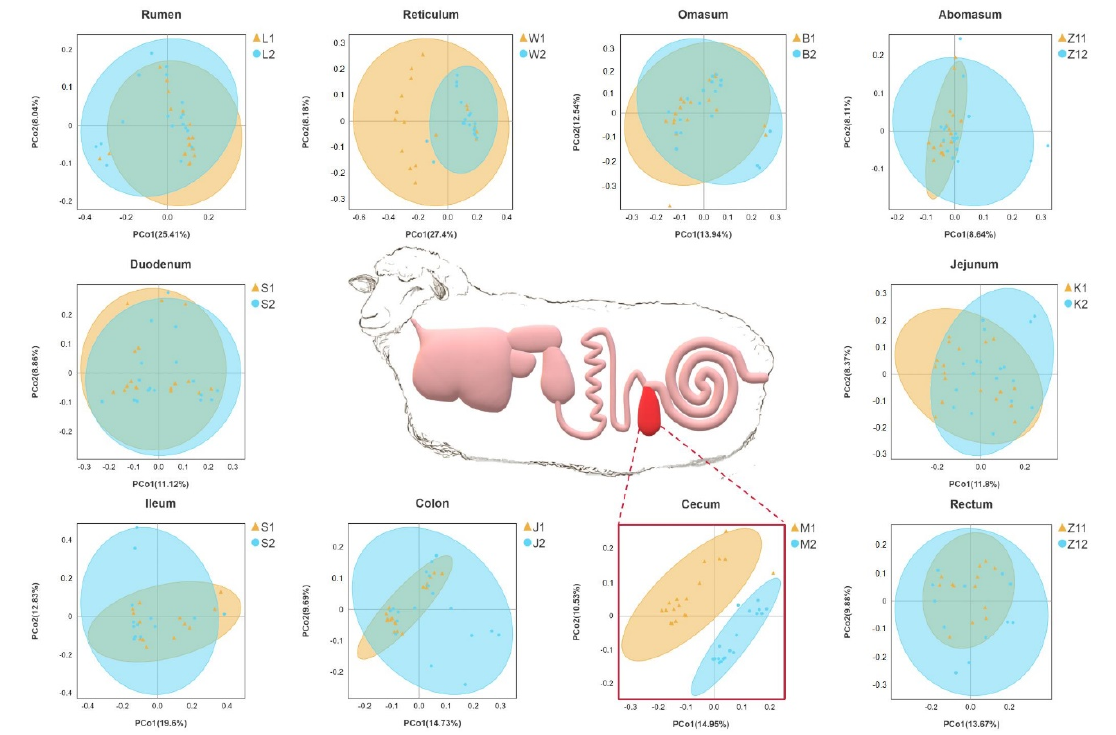
Figure 1. Gastrointestinal structure of Hu sheep. Principal coordinate analysis was performed on the basis of unweighted UniFrac distances to identify differences in microbial community structure across taxa. Sheep with high BMI showed round points, and sheep with low BMI showed triangular points. Table 3. Analysis of differences between MRPP groups.